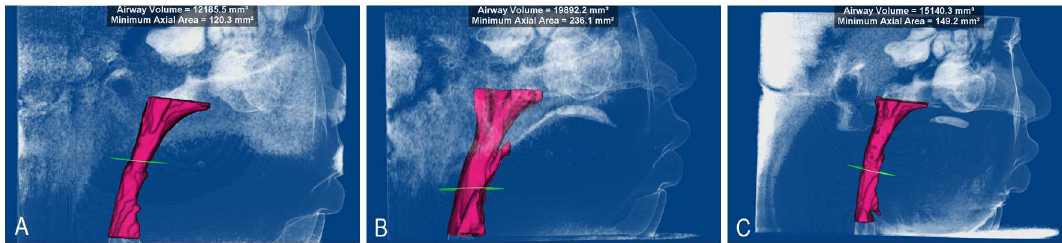
Fig 5. Preoperative upper airways of autogenous coronoid process graft reconstruction for the treatment of unilateral temporomandibular joint ankylosis at three points (A: T0 point; B: T1 point; C: T2 point).